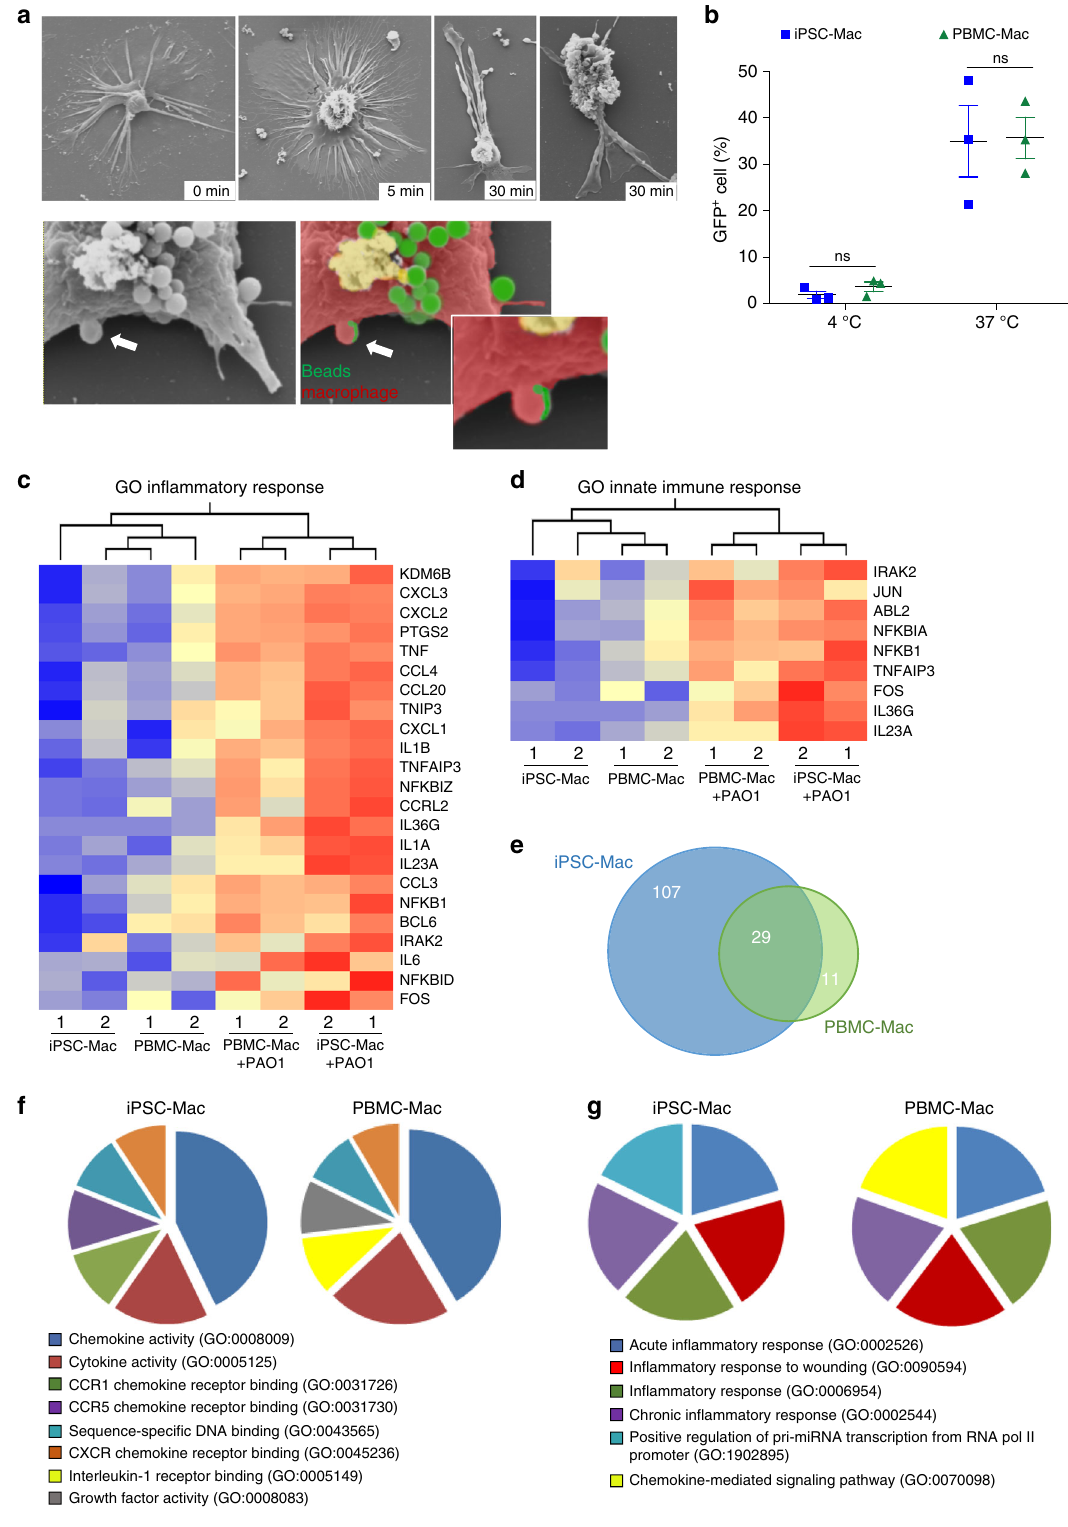
Fig. 3 Antimicrobial activity of iPSC-Mac generated in stirred tank bioreactors. a Scanning raster electron microscopy depicting phagocytosis of latex beads (green) by iPSC-Mac (red) at different time points. b Rate of phagocytosis by terminally differentiated iPSC-Mac (blue) and PBMC-Mac (green) after 2 h of incubation with GFP-labeled P. aeruginosa (PAO1) at 4 or 37 °C ( n = 3 of biological replicates, mean ± s.e.m, two-way ANOVA with Sidak ’ s multiple comparisons test, ns denotes not signi fi cant, representative data and gating strategy provided in Supplementary Figure 3a). c , d Heatmap of commonly regulated genes in iPSC-Mac and PBMC-Mac associated with ( c ) in fl ammatory response (GO:0006954; σ / σ max = 0.13, P < 0.05) and ( d ) innate immune response (GO:0045087, σ / σ max = 0.13, P < 0.05) after 1 h exposure to PAO1. e Venn-diagramm of >5-fold upregulated genes in iPSC-Mac (blue) and PBMC-Mac (green) after pathogen contact. f , g Top-ranked GOs associated with f biological processes and g molecular function (according to human gene atlas) of top 100 upregulated genes after 1 h pathogen contact (without pre-selection,